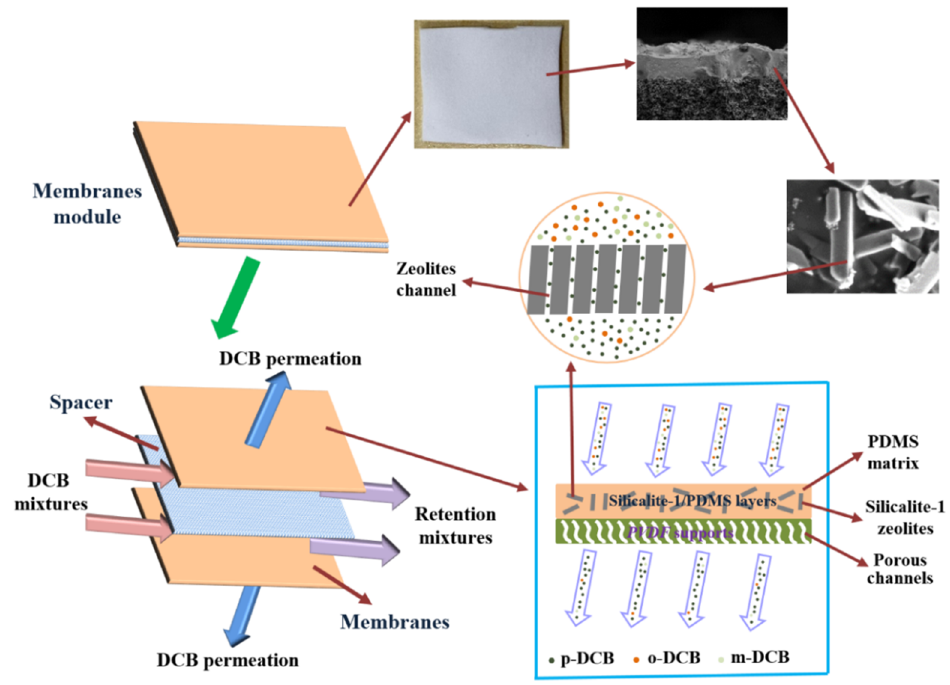
Figure 9. Schematic of the DCB isomers separation mechanism by silicalite-1/PDMS/PVDF hybrid membranes.